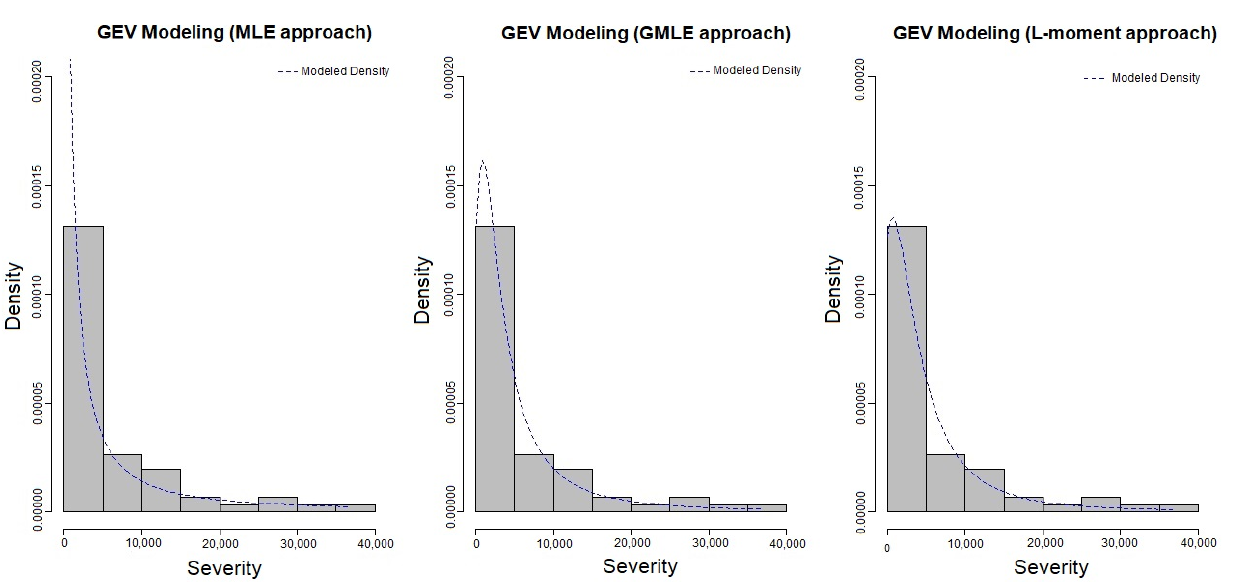
Figure 7. Comparison of GEV modeling using different estimation methods.